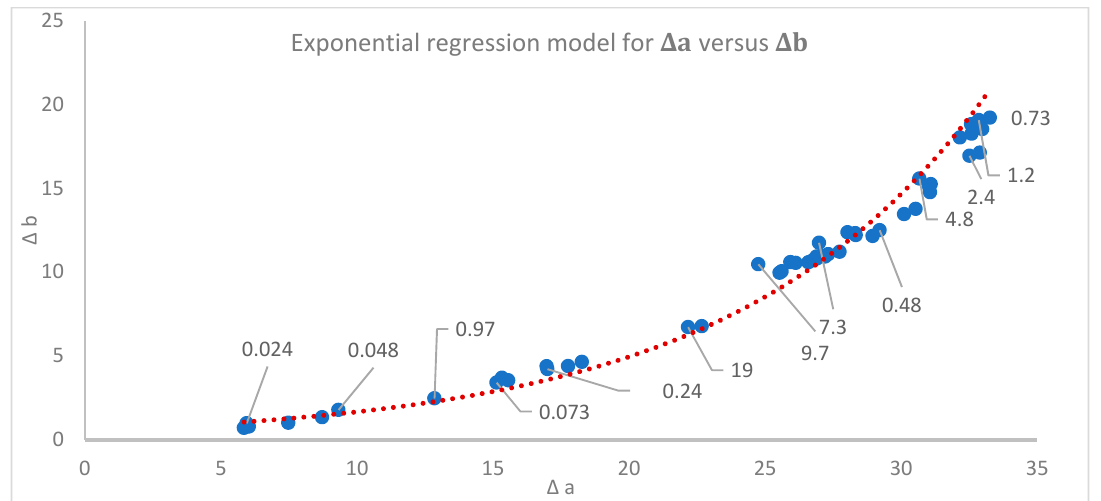
Figure 2. Exponential regression model for the color change relation between Δa and Δb color values for the crystal ‘Dramada’ in DCM. Labeled values are the corresponding pigment concentrations (mM). The color shift was not only quantified, but it was possible to visually assess the color change of the different concentrations (Figure 3).